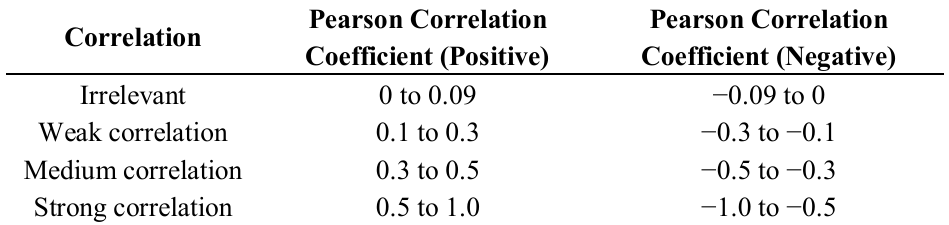
Table 1. Interpretation of the Pearson correlation